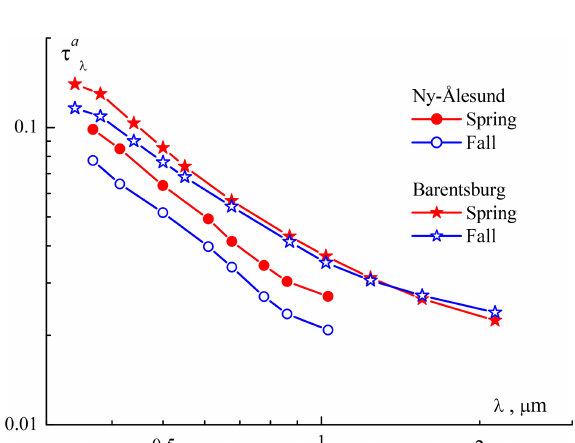
Figure 11. Average spectral dependences of AOD in two regions on Spitsbergen (2011–2018) during the spring (April–May) maximum and fall (August–September) minimum.